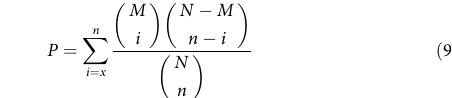
ffiffiffiffiffiffiffiffiffiffiffiffiffiffiffiffiffiffiffiffiffiffiffi (cid:3) log (cid:3)